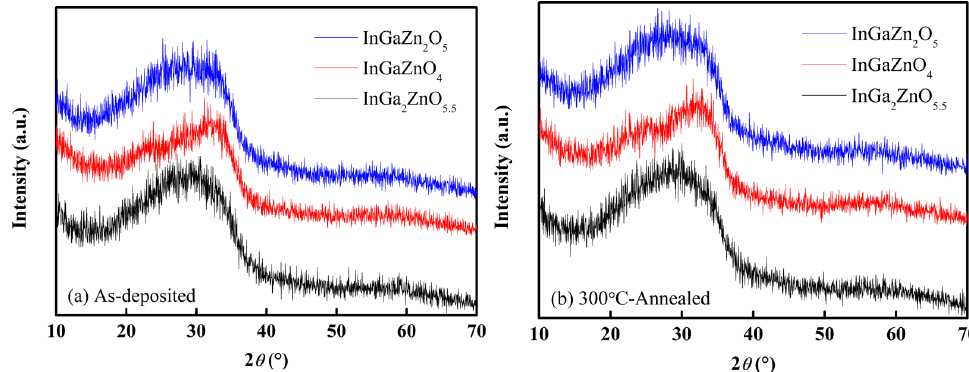
Figure 3. XRD patterns of ( a ) as-deposited and ( b ) 300 °C-annealed IGZO layers prepared by using IGZO targets with various Ga content ratios.